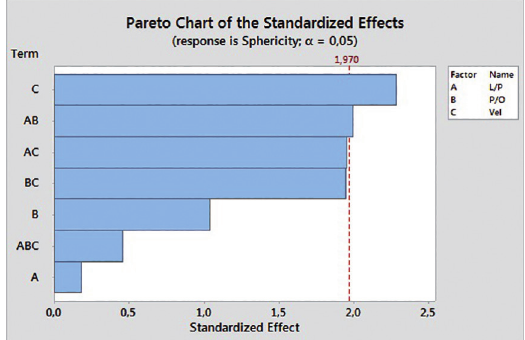
Figure 4: Pareto Chart of the standardized effects with a P-value < 0,05.